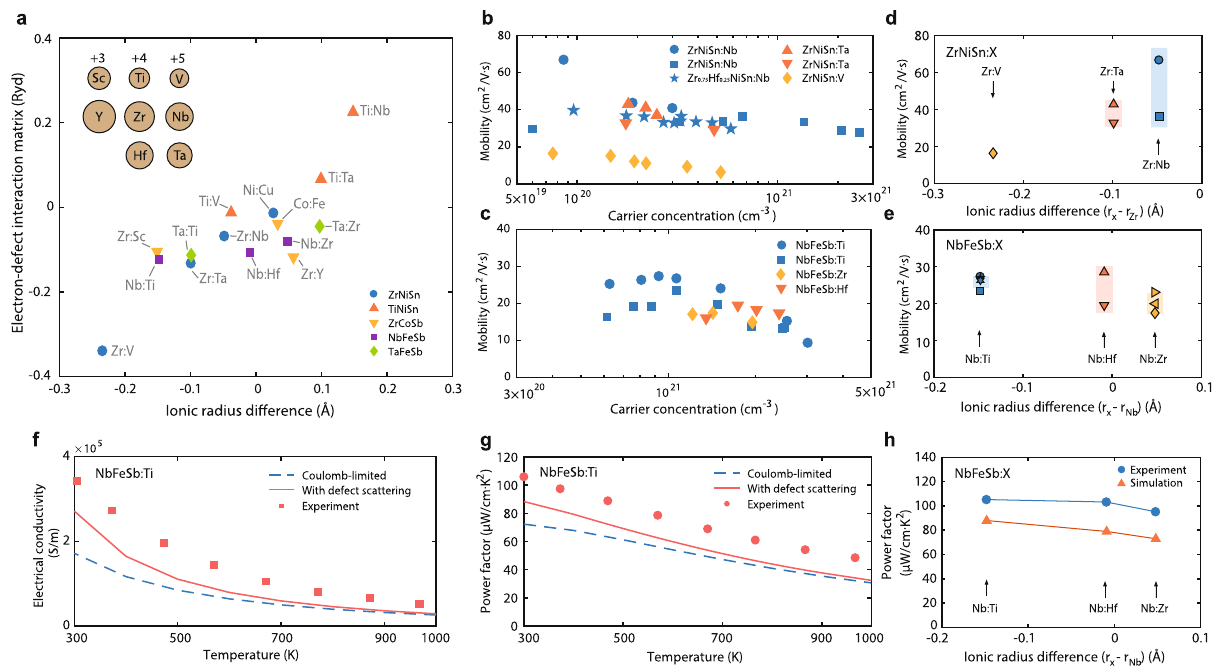
Fig. 3 Defect-mediated electrical and thermoelectric transport. a Correlation between ionic radius difference and the short-range electron-defect interaction matrix in half-Heusler materials with different dopants. Inset: relative sizes of the related atoms illustrated based on their ionic radius 22 , with the corresponding charges shown at the top of each column. The electron-defect interaction matrix is calculated for the band edge state. b , c Compiled experimental data for mobility dependence on the carrier concentration in representative half-Heusler materials with different dopants: b n-type ZrNiSn [experimental sources: ZrNiSn:V 43 ; ZrNiSn:Nb 27,44 ; Zr 0.75 Hf 0.25 NiSn:Nb 45 ; ZrNiSn:Ta 46,47 ], and c p-type NbFeSb [experimental sources: NbFeSb: Ti 29,48